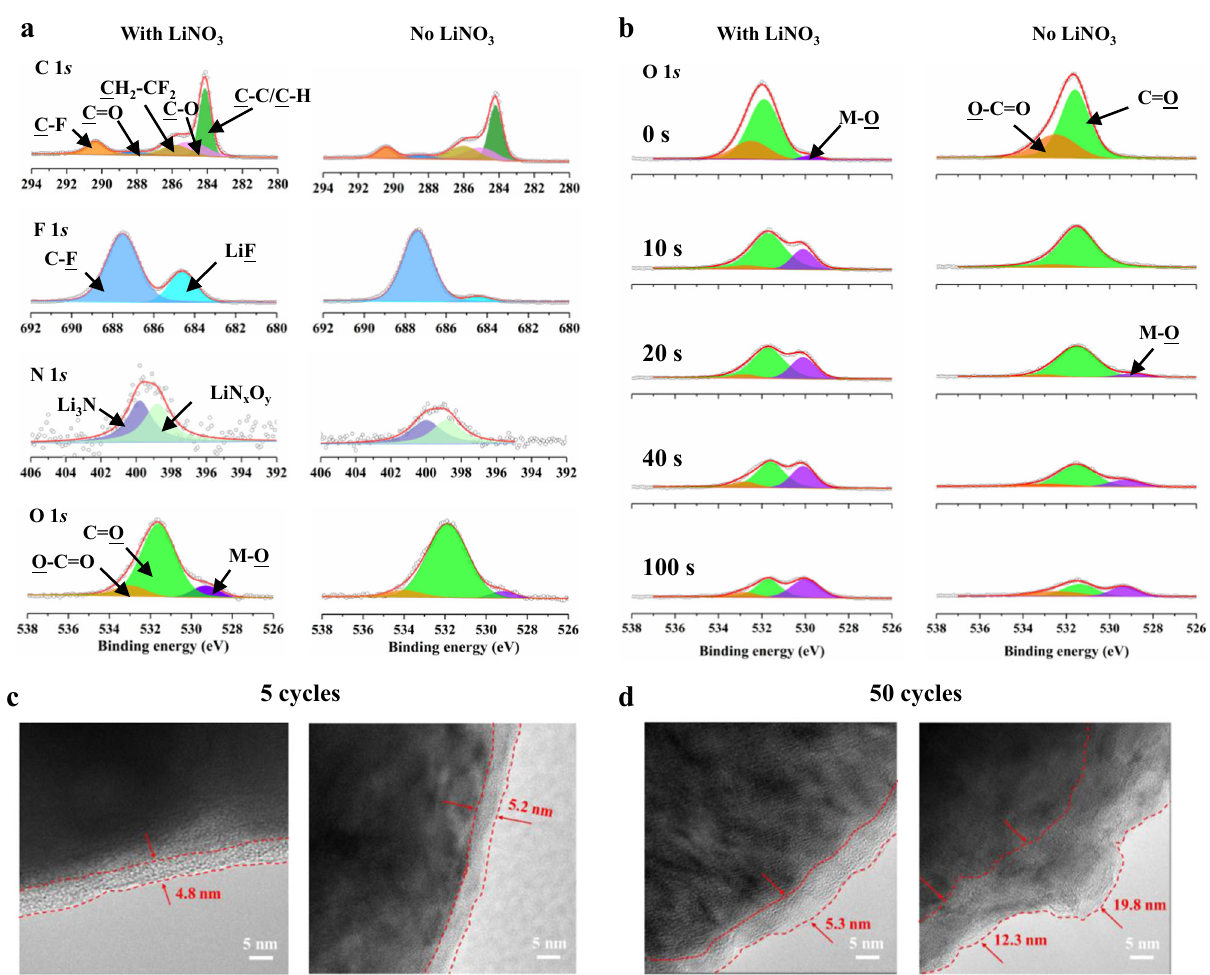
Fig. 4 Components on the surface of cathodes after cycling. a X-ray photoelectron spectroscopy (XPS) pro fi les of C 1 s , F 1 s , N 1 s , and O 1 s of CEI formed on NMC811 surface after 5 cycles and b XPS depth pro fi les of O 1 s of CEI formed on NMC811 surface after 50 cycles at 0.5 C in Li | |NMC811 coin cells with LiFSI/DME and LiFSI – LiNO 3 /DME electrolyte. HRTEM analyses of NMC811 cathodes obtained from Li/NMC811 cells using LiFSI/DME (right) and LiFSI – LiNO 3 /DME (right) after ( c ) 5 and ( d ) 50